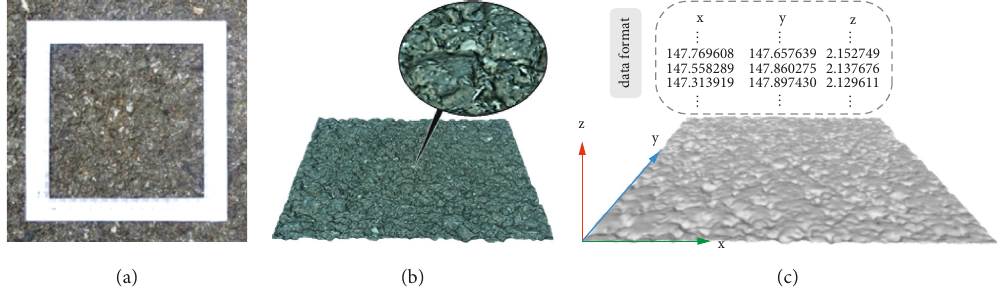
Figure 2: Acquisition of pavement texture information: (a) testing scope of pavement texture; (b) 3D model of pavement; (c) 3D data of texture